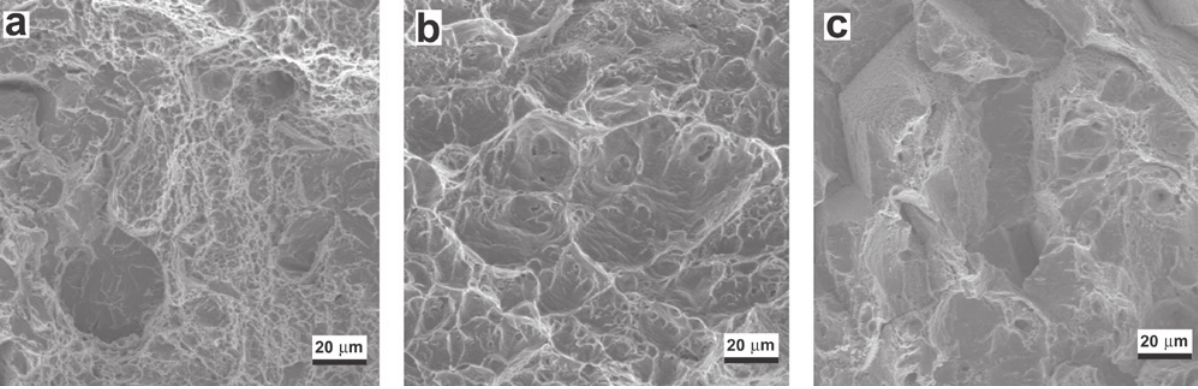
Fig. 10: SEM-fractographs of different regions of the studied weldment in thermally exposed state at 600 °C/5000 h after room-temperature tensile testing with hydrogen charging: T91 steel HAZ (a), Ni WM Thermanit Nicro 82 (b), TP316H steel HAZ